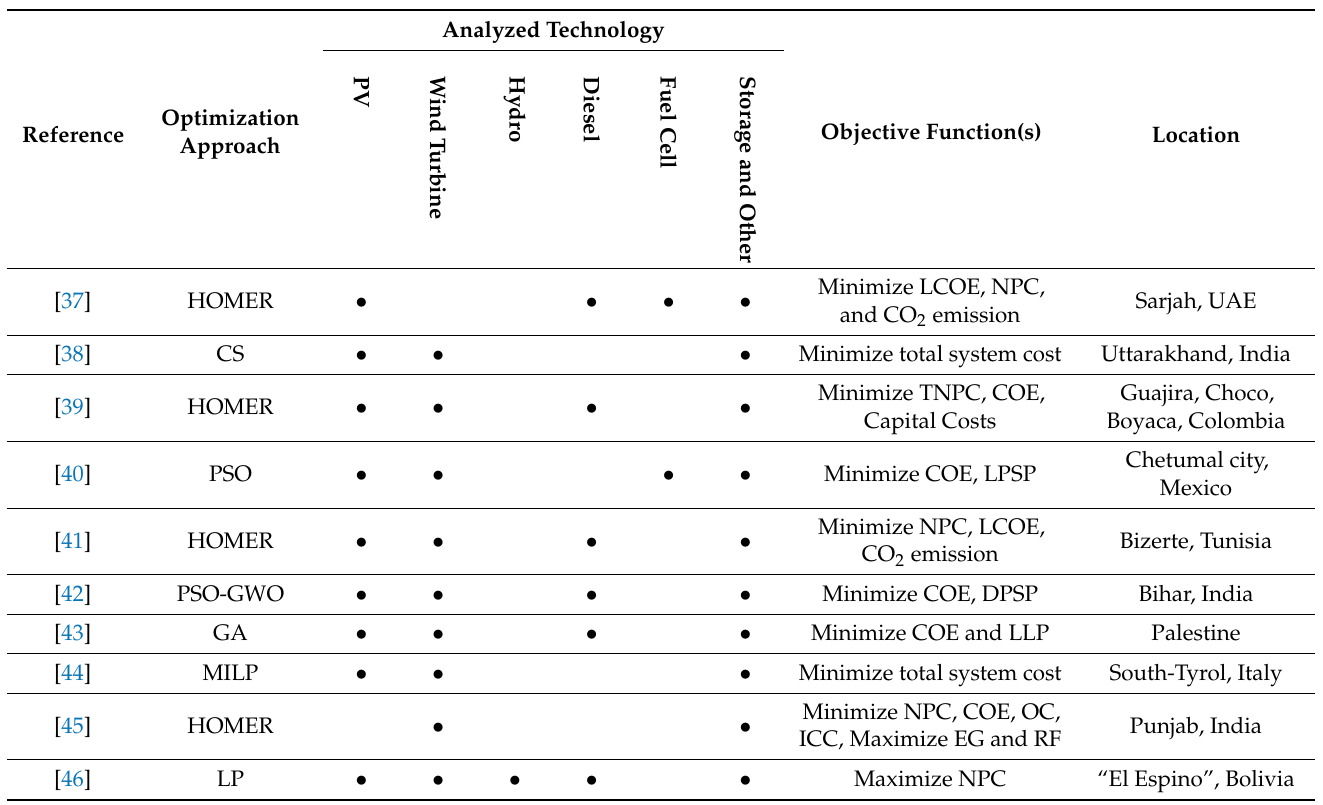
Table 1. Relevant studies surrounding